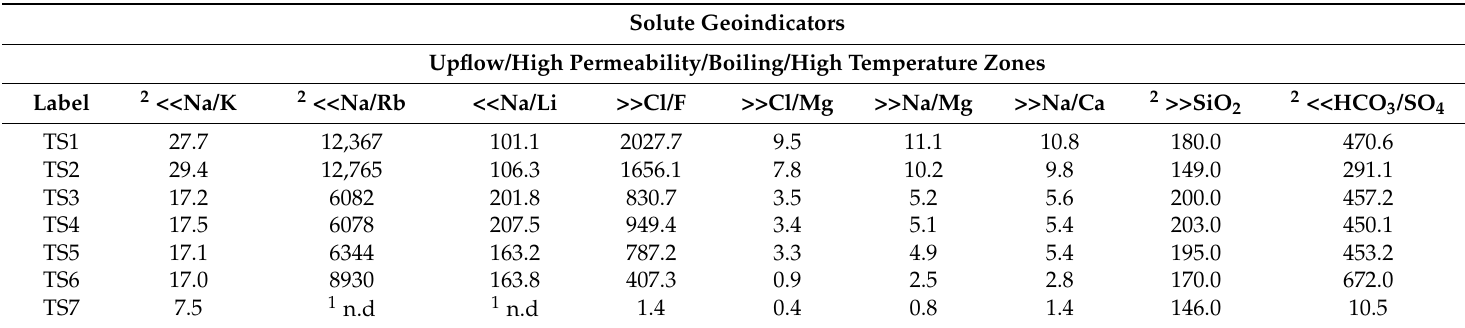
Table 6. Solute geoindicators for upflow, permeability, boiling process and high temperature